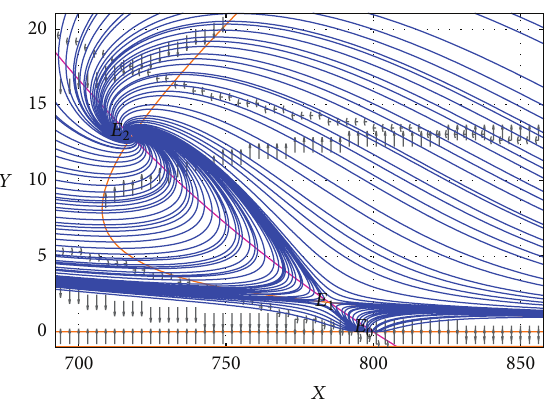
Figure 5: Phase plane of 𝑋 − 𝑌 with 𝐴 = 80 , 𝑑 = 0.1 , 𝑎 = 0.001 , = 1 , and 𝑐 = 0.5 (color 𝑏 = 0.01 , 𝑐 1 2